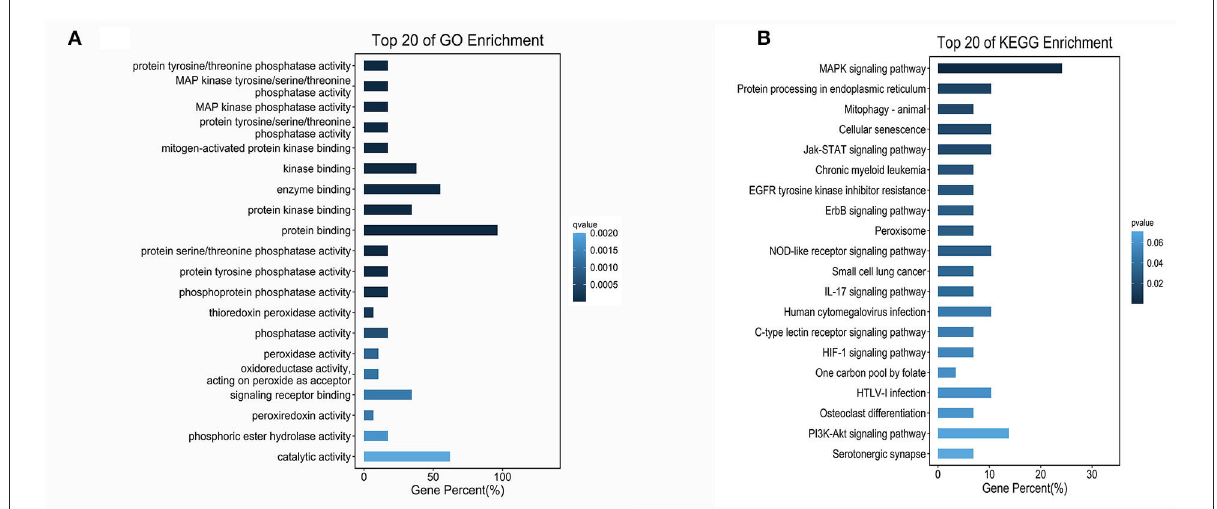
FIGURE2 GO and KEGG enrichment of lncRNA target mRNAs. (A) The bar plot shows the top 20 GO enrichment results of lncRNA target mRNAs in MFs. (B) The bar plot shows the top 20 KEGG enrichment results of lncRNA target